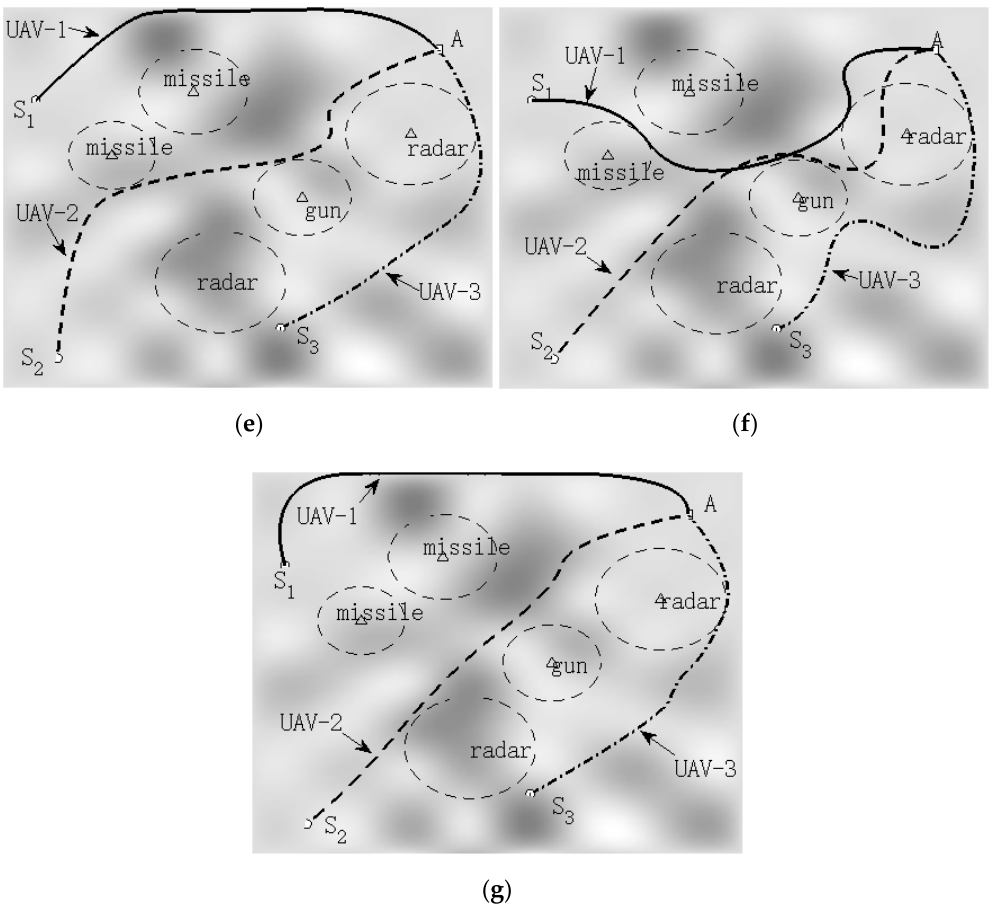
Figure 3. Two-dimensional displays of the best UAV paths obtained by ( a ) MSFOA, ( b ) FOA, ( c ) PSO, ( d ) DE, ( e ) ABC, ( f ) IFFO, and ( g ) MFOA in the second scenario.